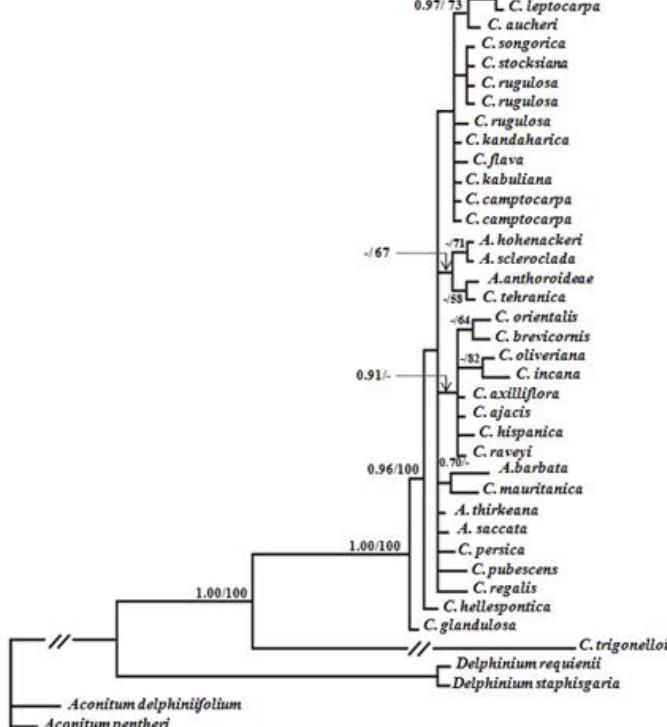
Fig. 1. Bayesian inference tree of trn L-F data set in Consolida species: Numbers above the branches or arrows indicate Bayesian posterior probabilities (PP) and maximum parsimony bootstrap (MP). Values < 50% not shown. (C. tehranica =A. tehranica)